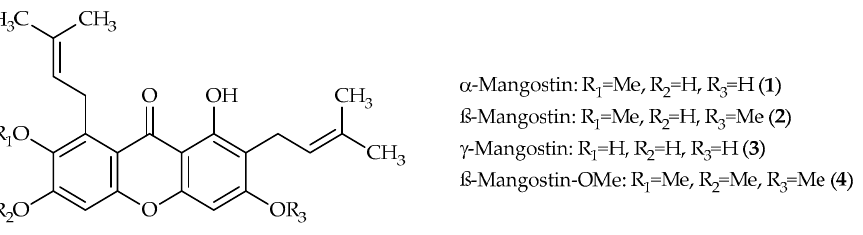
Figure 2. Prenylated xanthone derivatives from Garcinia mangostana